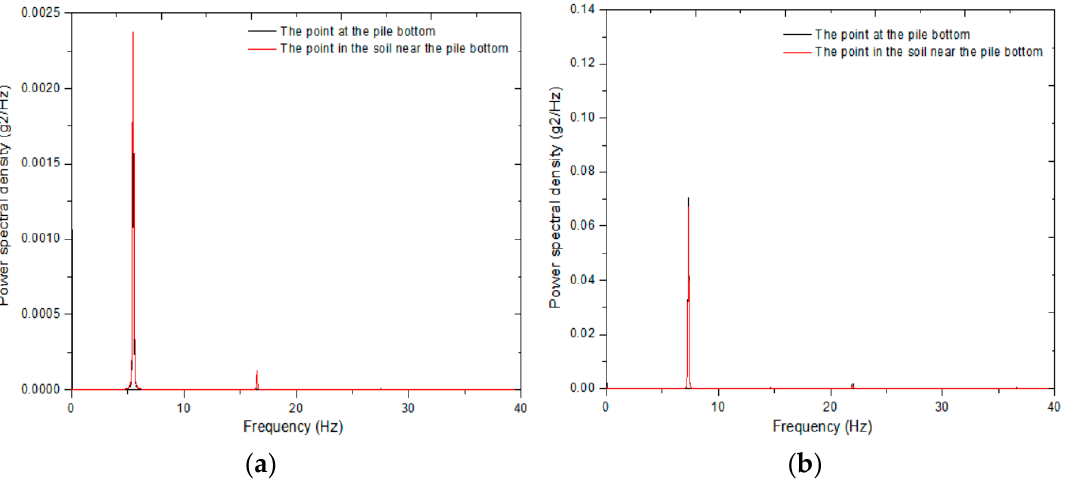
Figure 15. Acceleration Auto-power Spectrum Density curves of “Adjacent” Measuring Points at Soil-Pile Interface: ( a ) S5-1, ( b ) S10.